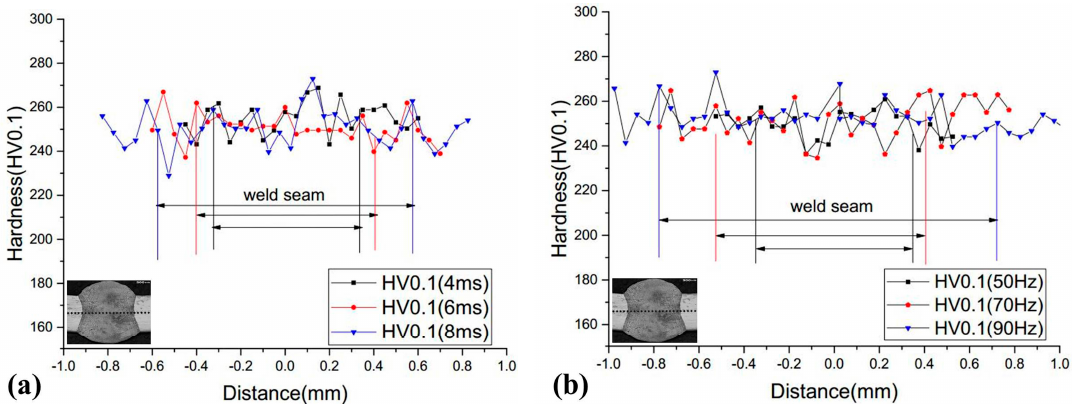
Figure 13. Variations of microhardness of the weld with pulse duration and frequency: ( a ) Microhardness profiles for the welds with different pulse durations; ( b ) Microhardness profiles for the welds with different pulse frequencies.